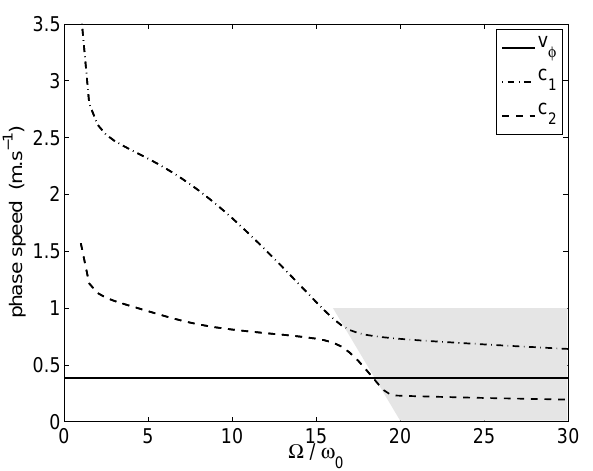
Fig. 6. Caption as for Fig. 5, for stratification